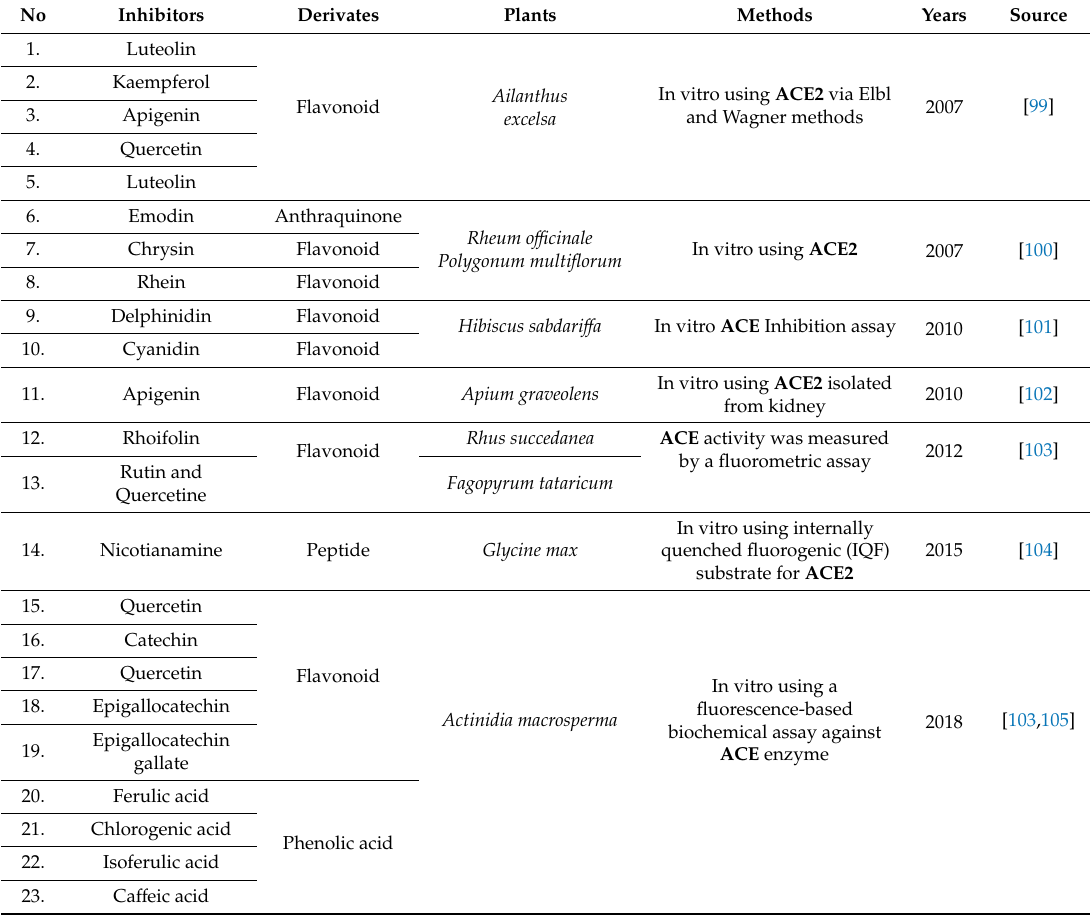
Table 1. Bioactive compounds reported to inhibit ACE1 and ACE2 in the